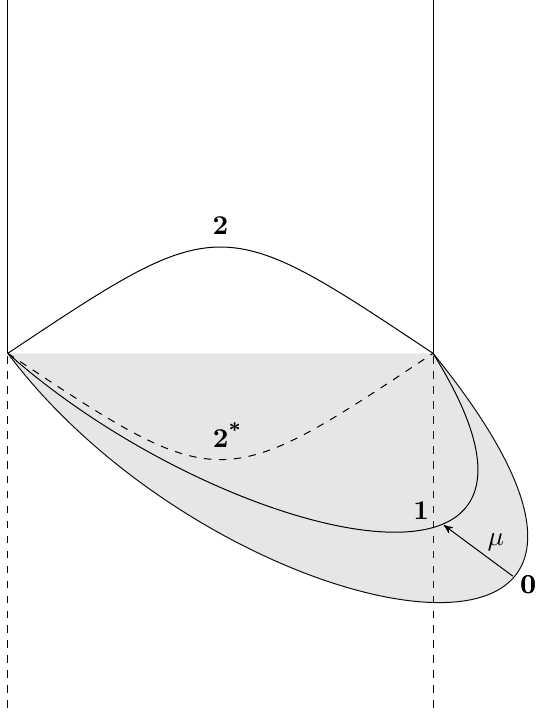
Figure 2 . The evolution of the embedding of the slice Σ , with a given fixed metric, under the deformation parametrised by µ , in a saddle-point approximation. The illustration shows a (complexified) AdS cross-section of the AdS vacuum geometry. The Euclidean CFT boundary 2 d +1 is labelled by 0 , in a conformal frame where its geometry is hyperbolic. Three different stages ( 0 , 1 and 2 / 2 * ) of the deformation are shown. Stage 0 corresponds to no deformation of the CFT. As we perform the T 2 deformation the slice moves inwards along the imaginary time direction, while still being embedded in a Euclidean bulk space (stage 1 ). For a sufficiently large deformation there is a phase transition to a Lorentzian saddle-point bulk geometry. By time-reversal symmetry, the slice Σ can be embedded in two different ways in the same bulk geometry (with the same intrinsic metric). This corresponds to stages 2 and 2 * . From the perspective of the field theory, this phase spontaneously breaks time-reversal (and therefore CPT